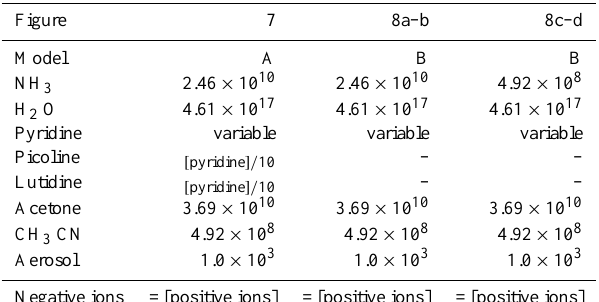
Initial concentrations in cm − 3 for the simulations presented in Figs. 7 and